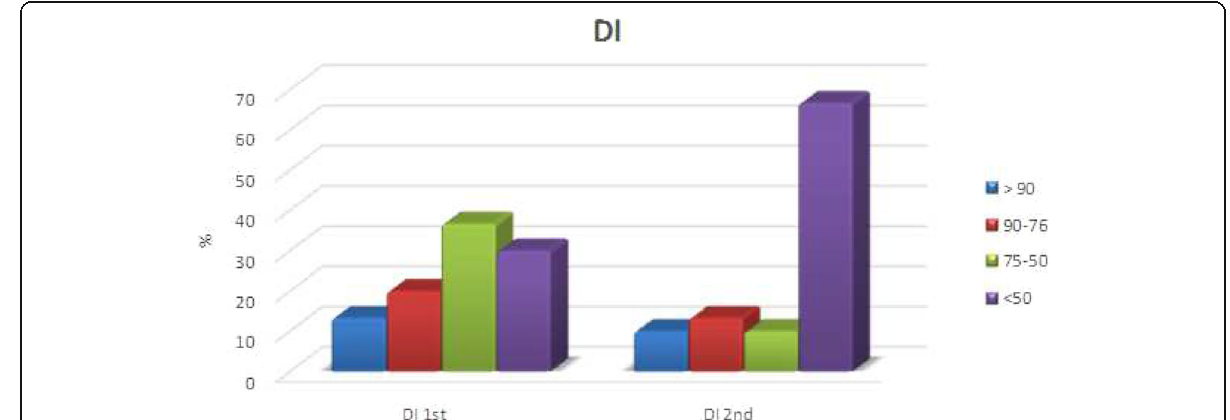
Fig. 2 DI among the studied patients at 1st and 2nd